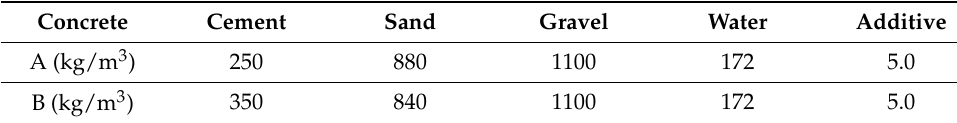
Table 3. Concrete mix design (kg/m 3 ).